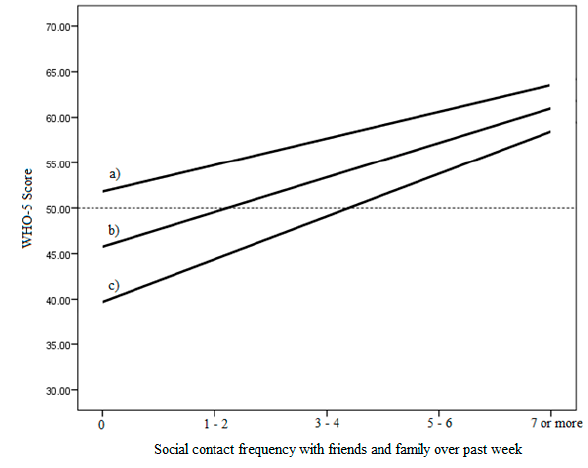
Figure 2. Simple slopes graph depicting conditional relationship between social contact frequency and subjective wellbeing: (a) at 1 standard deviation above the mean; (b) at the mean; (c) at 1 standard deviation below the mean of nature visit frequency. The dashed horizontal line depicts the threshold below which wellbeing is considered low [105].